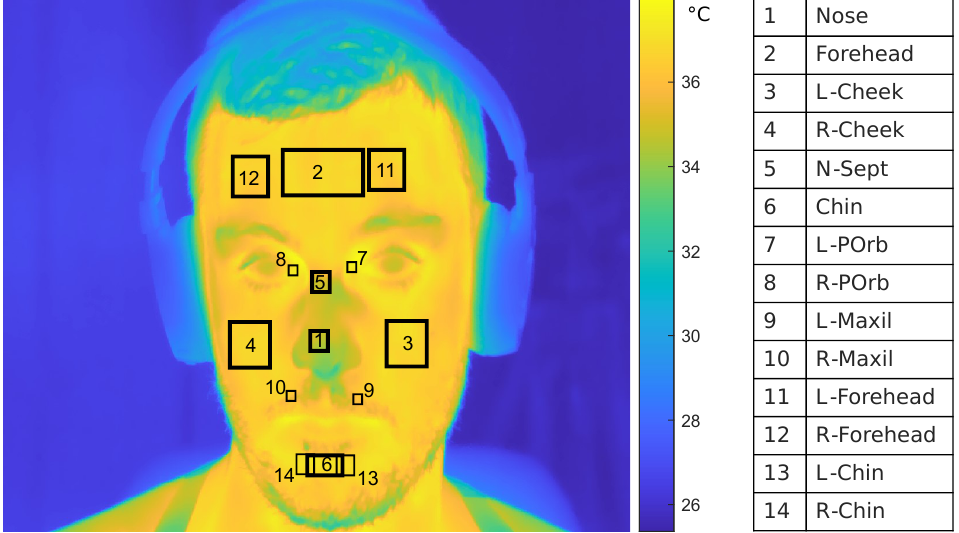
Figure 2. Facial ROIs’ names and corresponding